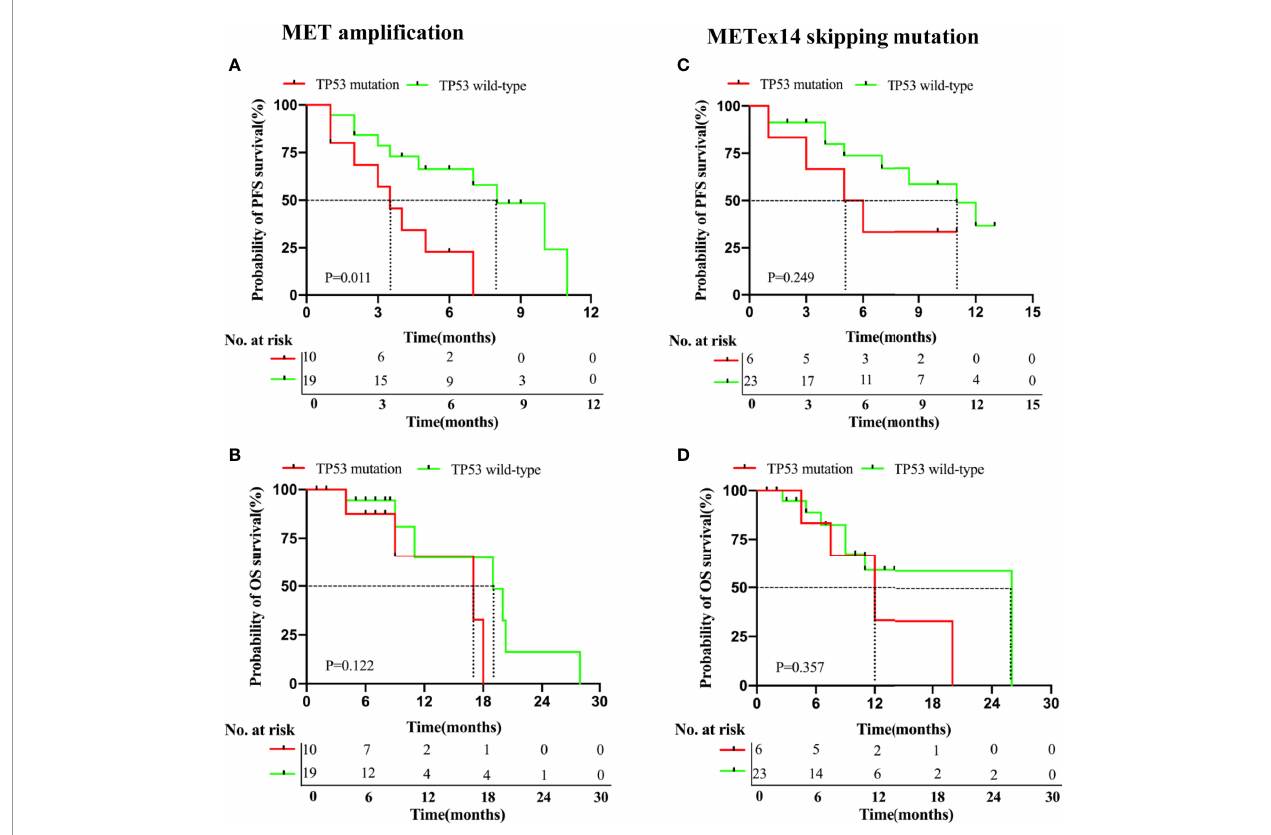
FIGURE 4 | NSCLC patients with MET ampli fi cation and METex14 skipping mutation harboring TP53 mutations have deleterious survival outcomes with MET TKI therapy. Kaplan-Meier curves of PFS (A, C) and OS (B, D) of patients treated with MET TKIs based on presence or absence of concurrent TP53 mutation in MET ampli fi cation and METex14 skipping mutation cohorts.